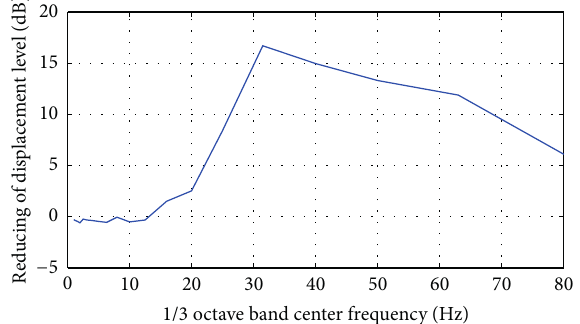
Figure 12: RDL on the location of 2m behind open trench ( 𝐿 = 10m, 𝑊 = 1m, and 𝐻 = 3 m; Poisson’s ratio ] = 0.25; train speed 𝑉 = 300km/h).